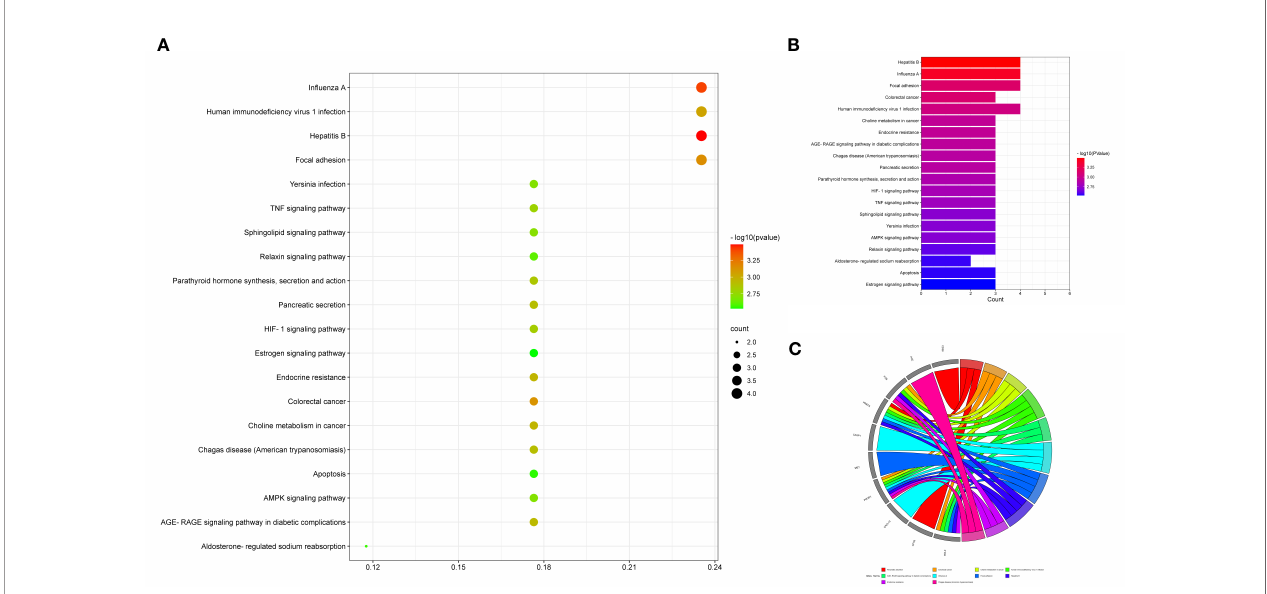
FIGURE 5 | Enrichment analysis exhibited KEGG data of luteolin in treating PC and COVID-19, as characterized in the bubble graph (A) , histogram graph (B) , and circle chart (C)